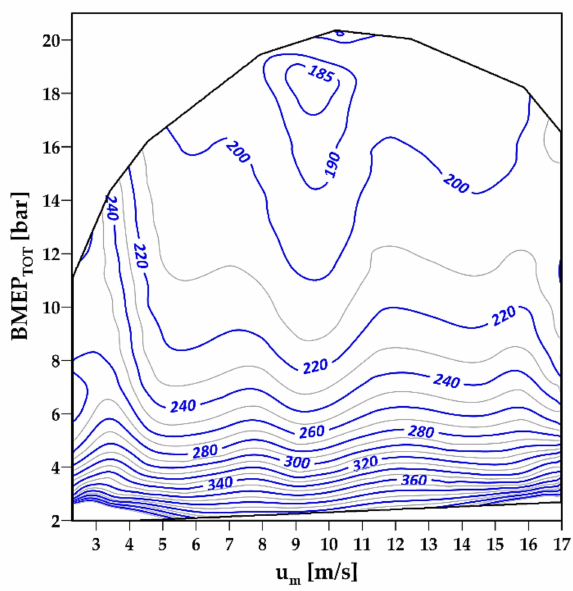
Figure 16. Brake specific fuel consumption (g/kWh) of the compound engine, as a function of the overall load and mean piston speed ( T 4 /T 1 = 4.0, η T =